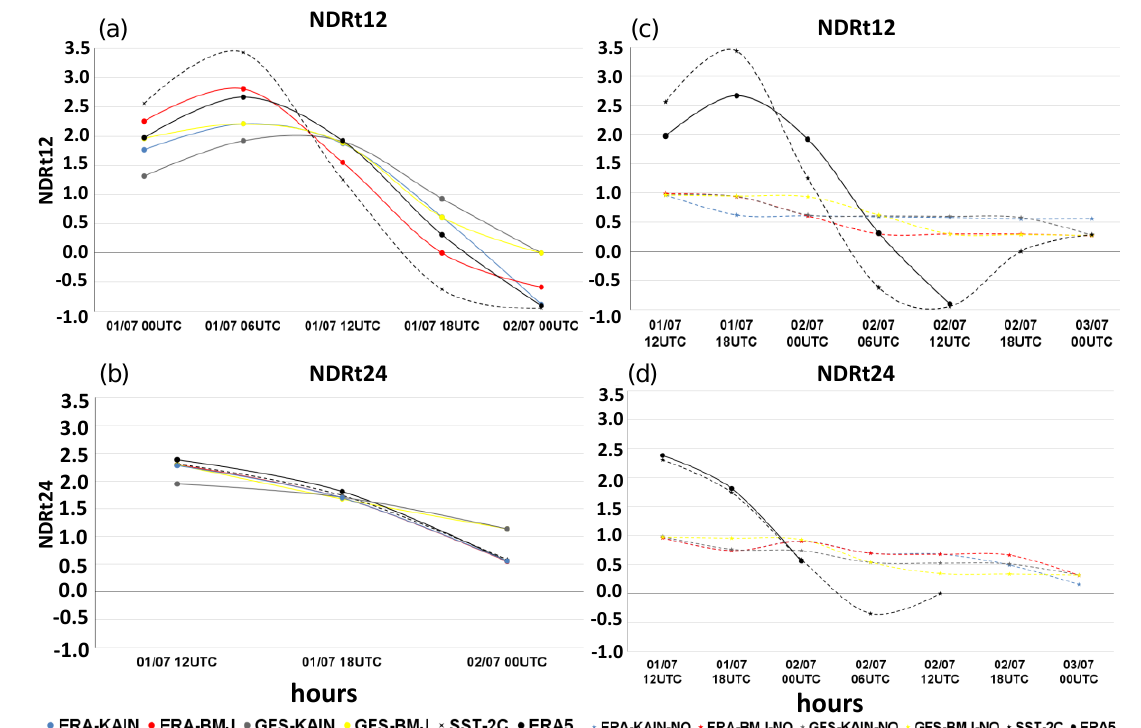
Figure 7. NDR t12 ( b ) NDR t24 computed for each experiment following Zhang et al. [2] and SG, respectively. ( a , b ) for the experiments with the turbulent heat fluxes turned on and ( c , d ) turned off. The horizontal axis indicates the final value of each interval used in the calculus. For example, in NDR t12 , the first calculus is between 1200 UTC 30 June to 0000 UTC 1 July 2020. Hence, in the horizontal axis 0000 UTC 1 July 2020 is shown.